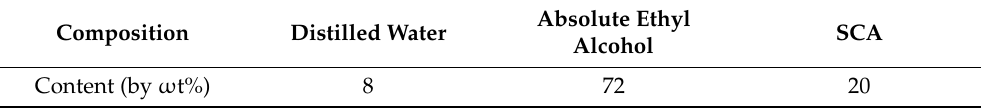
Table 3. The composition of the SCA solution.